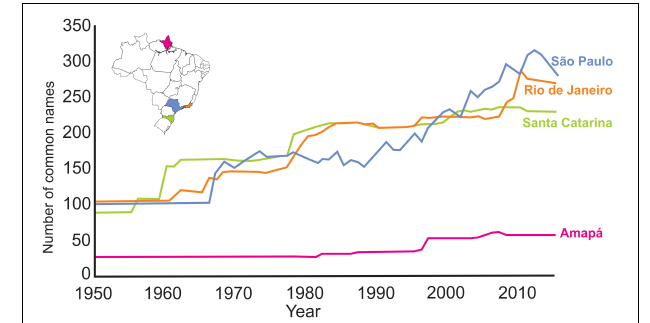
FIGURE 4 | Number of common names reported in the reconstructed landing database of marine commercial fisheries for four Brazilian coastal states (1950–2015): Amapá, with almost no change during the time period analyzed and the states of Rio de Janeiro, São Paulo, and Santa Catarina where an increase in the number of common names was observed. All other states were between these two extremes (not